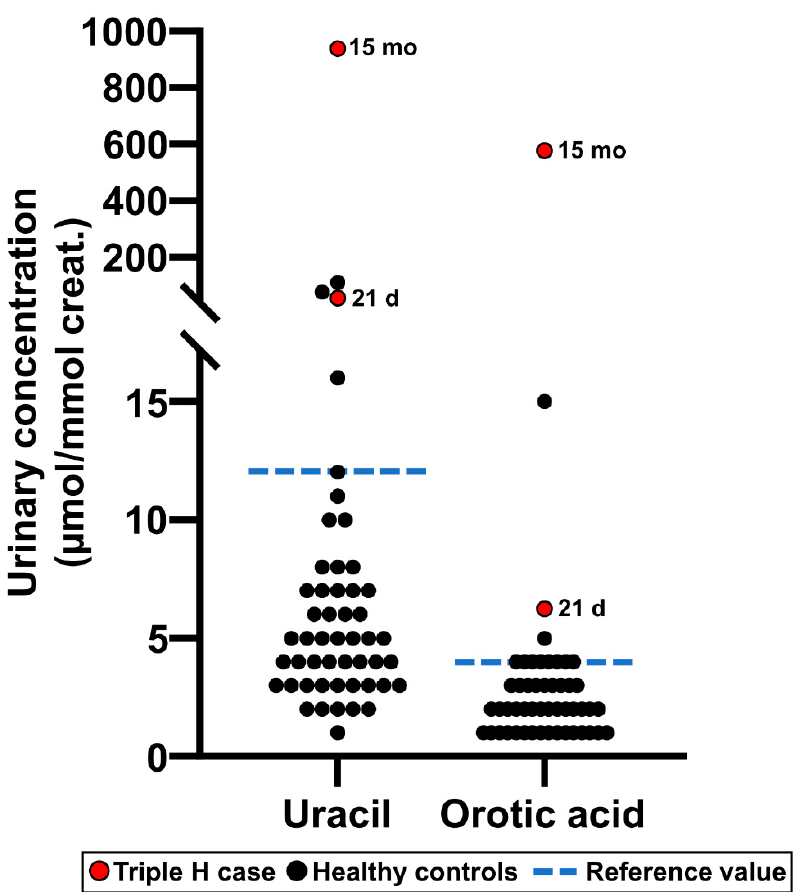
Figure 8. Uracil and orotic acid urinary concentrations measured as part of the Organic acids second-tier test in a patient affected with Triple H syndrome, both at 21 days of age (this specimen was collected as part of the newborn screening program) and at 15 months of age. Values measured in healthy reference controls ( n = 50) are also shown for comparison purposes.